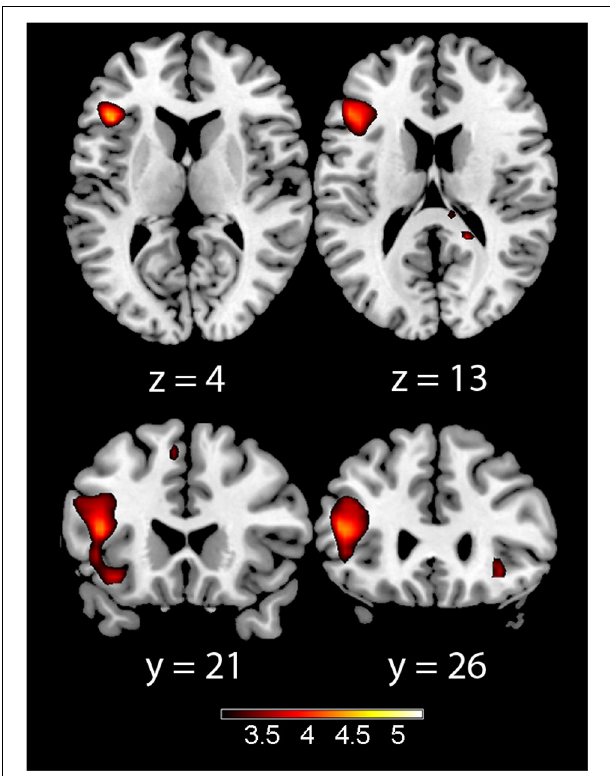
FIGURE 1 | Acquisition phase trials (early and late acquisition combined) for the incongruent > congruent contrast. Showing left insula (left) and left inferior frontal gyrus pars trianglaris (right) on axial (top) and coronal (bottom) slices, Color map represents t -values.